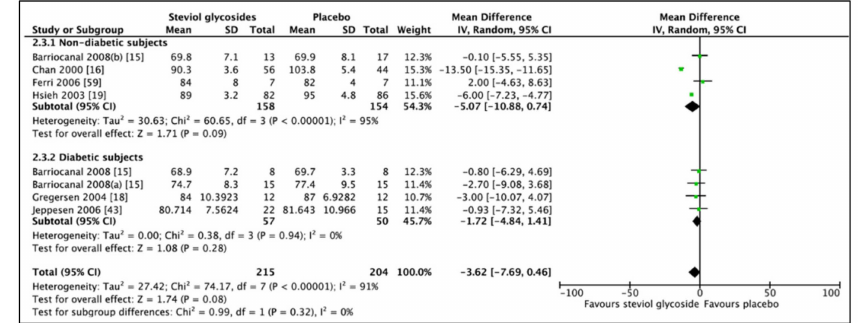
Figure 6. E ff ect of SGs on diastolic blood pressure (DBP, mmHg) CI: confidence interval; MD: mean di ff erence; RCTs: randomized controlled trials; SD: standard